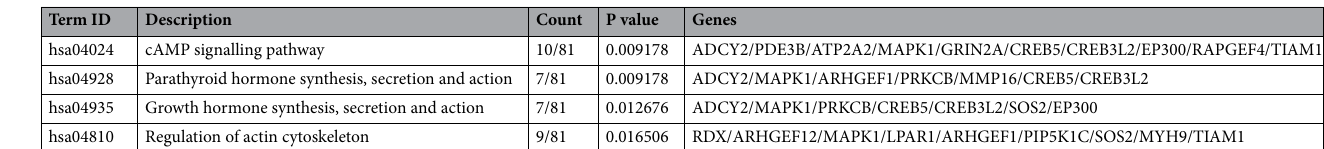
Table 5. Top 4 enriched KEGG pathways associated with quantitative renal trait Log Creatinine. Term ID; KEGG pathway identification, Description; descriptor of enriched KEGG pathway, Count; number of feline genes enriched within given KEGG pathway, %; percentage of feline genes compared to genes in KEGG pathway, P value; significance, Genes; feline genes associated with enriched KEGG